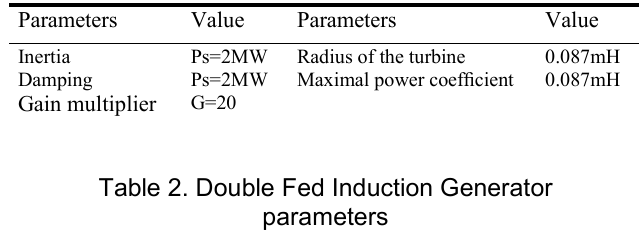
Table 2. Double Fed Induction